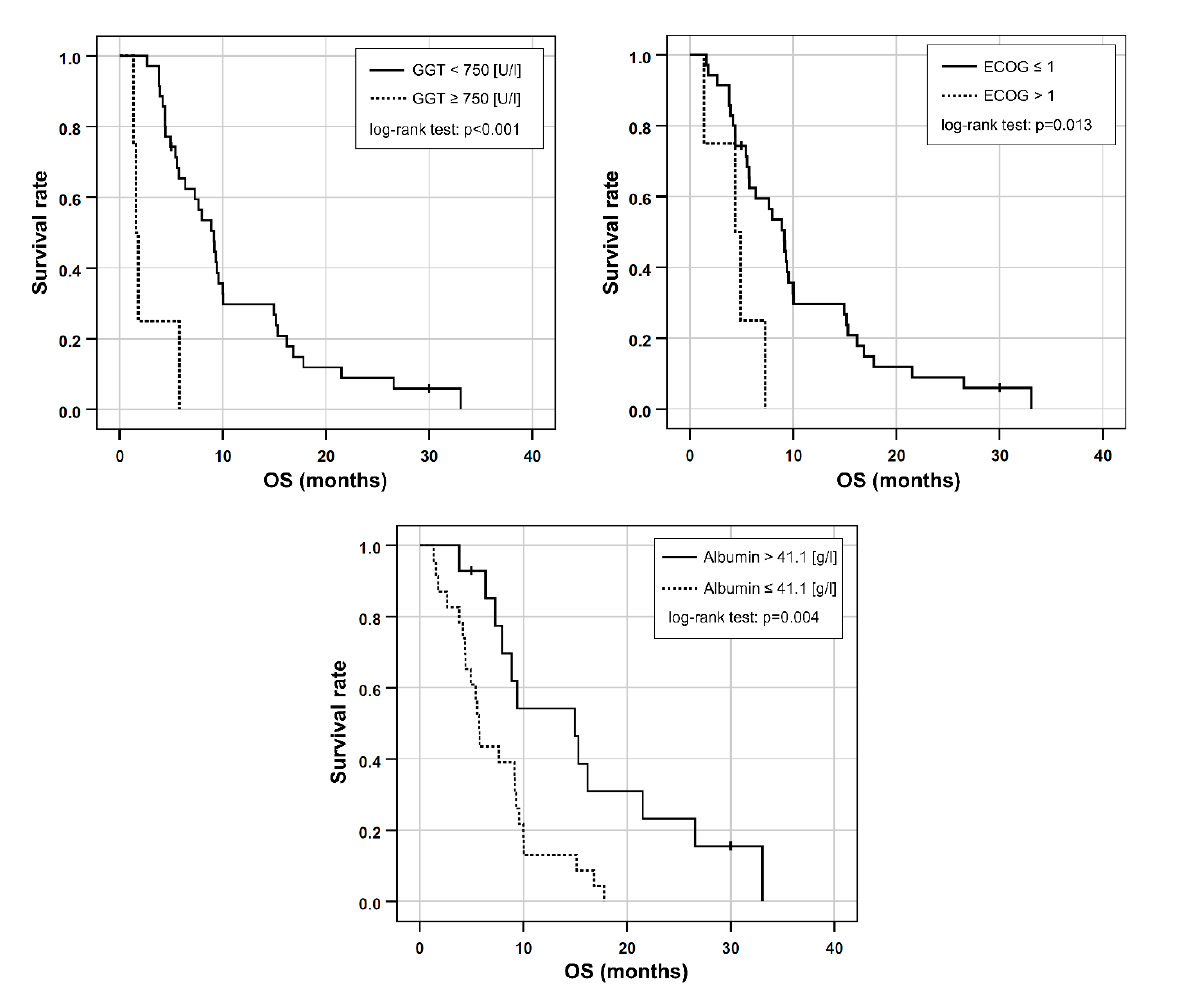
Figure 2. Kaplan-Meier plots for OS in patients separated either by their elevated GGT, ECOG performance status or by albumin reduction at baseline.